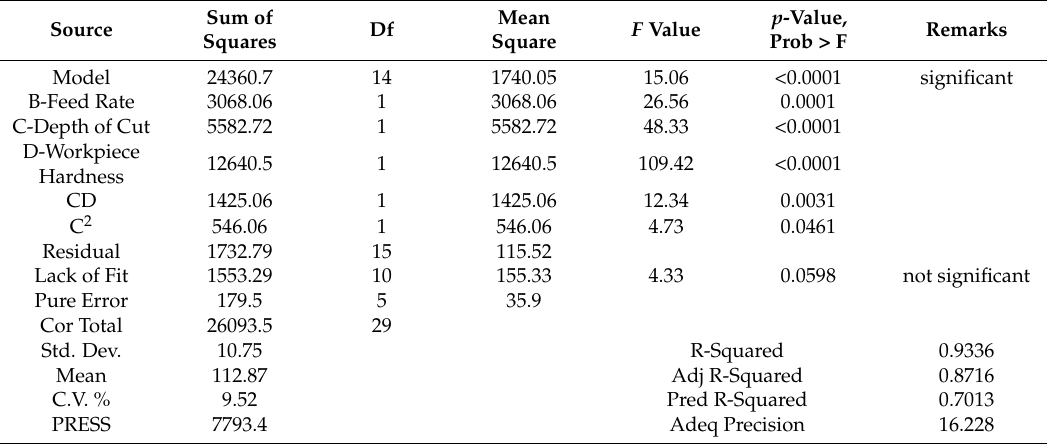
Table 11. Model of Thrust Force for CBN-I Insert.